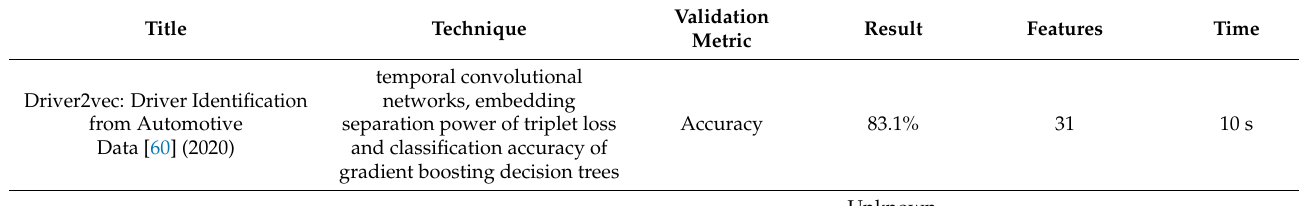
Table 5. Results obtained from proposed work from past investigations that also use simulations